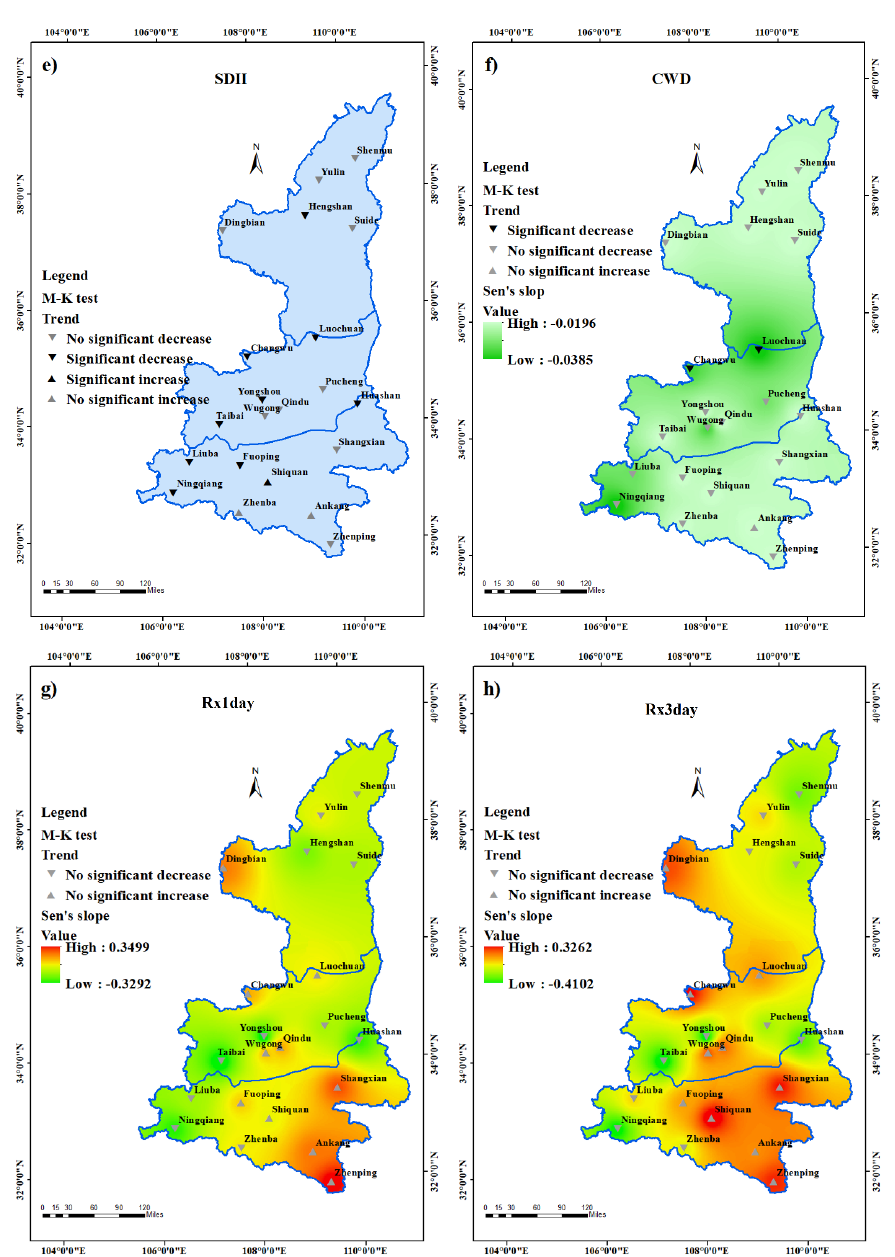
Figure 6. Mann–Kendall trend test and Sen’s slope distribution of ( a ) PRCPTOT, ( b ) wet days, ( c ) R25, d ) R50 and ( e ) SDII, ( f ) CWD, ( g ) Rx1day, ( h ) Rx3day. (Note: Since the Sen’s slope value of R50